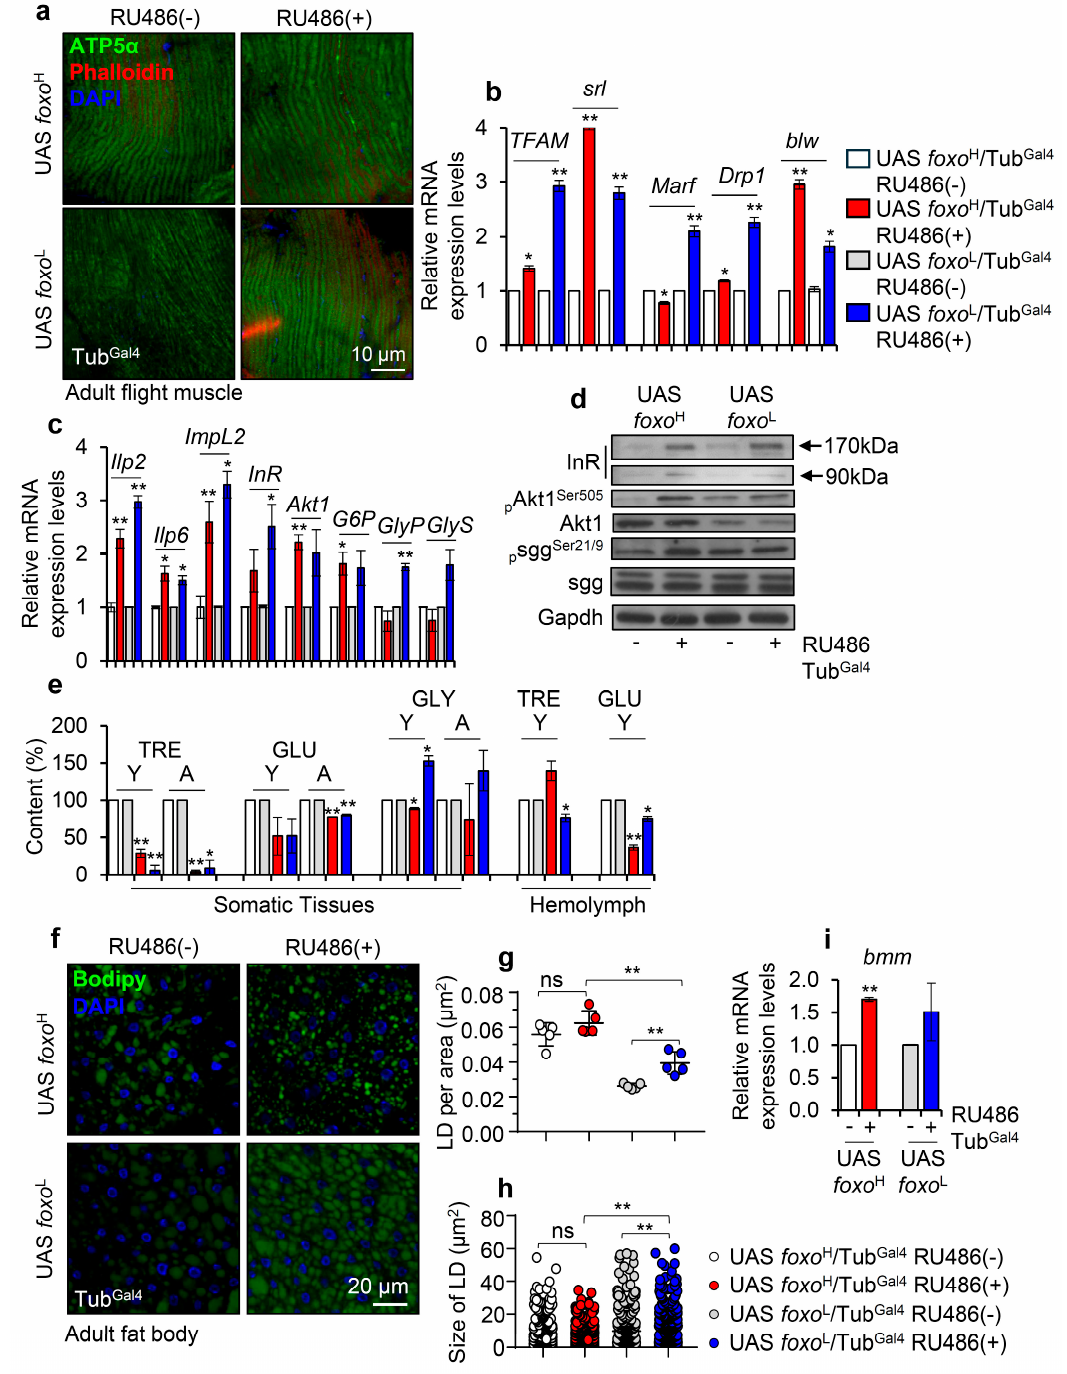
Figure 2. Perturbation of major bioenergetic and metabolic signaling pathways after ubiquitous foxo OE in Drosophila flies. ( a ) Representative CLMS images of female adult middle-aged foxo overexpressing, or control flies’ muscle fibers stained with anti-ATP5a (mitochondrial subunit). ( b ) Relative expression levels of mitochondrial ( TFAM , srl/PGC1 α , Marf , Drp1 , blw/ATP5a ) genes in shown transgenic flies. ( c ) Relative expression levels of Ilp2 , Ilp6 , ImpL2 , InR , Akt1 , G6P , GlyP , and GlyS genes (bars are as in b ) and, ( d ) representative immunoblotting analysis showing expression levels of insulin receptor (InR), p Akt1 Ser505 (phosphorylated activated form), total Akt1, p sgg Ser21/9 (phosphorylated inhibitory form) and total sgg in indicated foxo overexpressing flies; Gapdh probing was used as a loading reference. ( e ) Content (%) of TRE (trehalose), GLU (glucose), and GLY (glycogen) in dissected somatic tissues or isolated hemolymph from middle-aged foxo overexpressing transgenic flies (bars are as in b ); controls were set to 100%. ( f ) Representative CLSM images of lipid droplets (LDs) (Bodipy staining, green); nuclei were stained with DAPI (blue); ( g ) quantification of LDs’ number [LDs per area ( μ m 2 )] and, ( h ) measurement (in μ m 2 ) of LDs’ size in the fat bodies of female middle-aged foxo overexpressing transgenic flies. ( i ) Relative mRNA ex- pression levels of bmm (also known as ATGL ) after foxo OE. In ( b – d , i) , expression of transgenes was induced by 320 μΜ RU486 for 7 days; data refer to dissected young flies’ somatic tissues. In